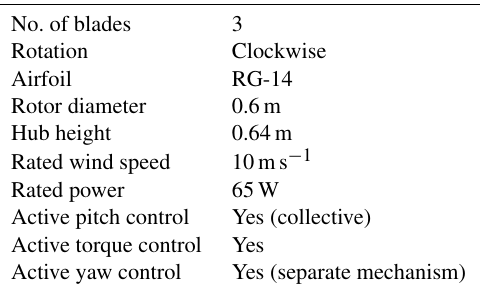
Table 1. Basic characteristics of the G06 scaled